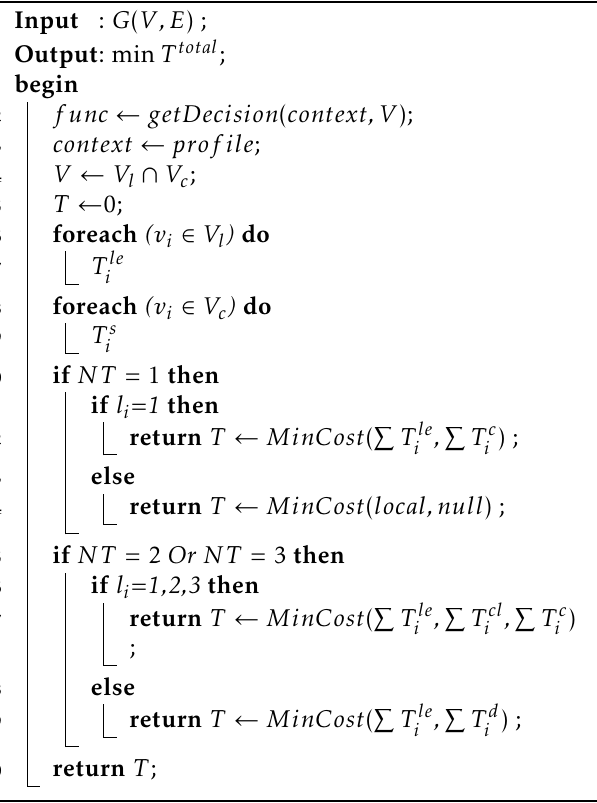
Algorithm 2: Adaptive Task O ffl